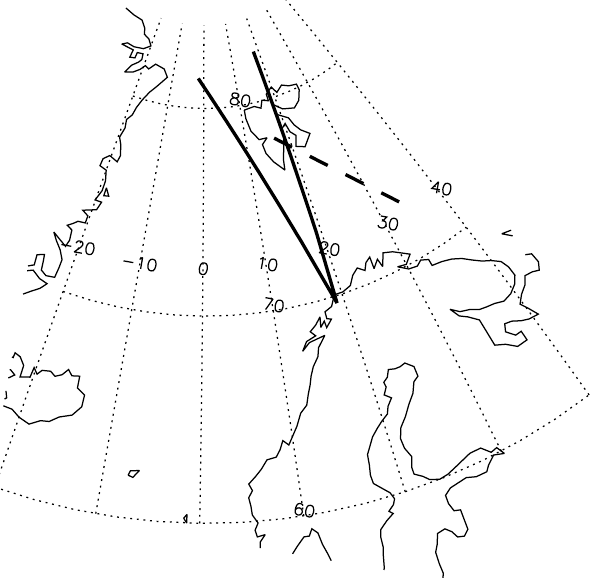
Fig. 1. The beam directions, mapped down to 100km, for the EIS- CAT VHF radar in Tromsø (solid lines) on 28 November 2000 and for the EISCAT Svalbard radar (dashed line) on 7 December 2000 shown in geographic coordinates.